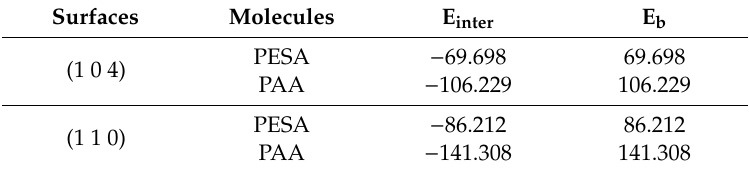
Table 1. The interaction energy (kcal/mol) of the two compounds with calcite (1 0 4) and (1 1 0) surfaces.